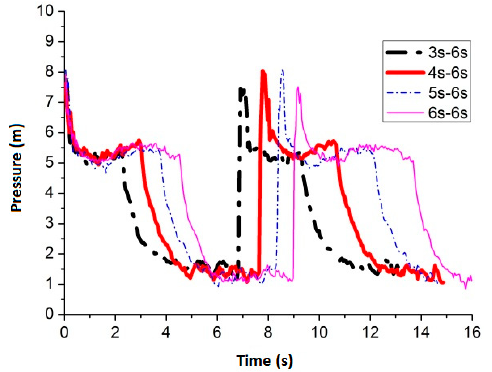
Figure 28. The four best pressure values when the slot nozzle is set at the bottom of the pipe.